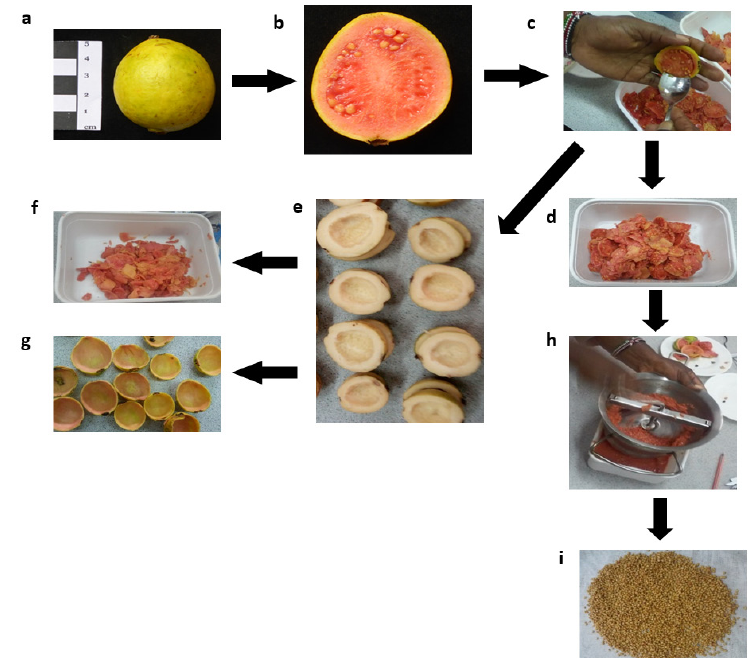
Fig. 2: Guava fruit and fruit parts used in morphological characterization: (a) entire guava fruit, (b) fruit longitudinally cut into two parts, (c) pulp and seed removed with a spoon, (d) seed and pulp, hence their combined weight measured (e) pericarp, hence pericarp thickness and weight measured, (f) mesocarp removed from pericarp with a spoon and weight measured, (g) fruit exocarp/skin after removing the mesocarp, thickness and weight mea- sured, (h) seed and pulp separated by a fruit mill and pulp weight measured, and (i) guava seeds washed and dried for